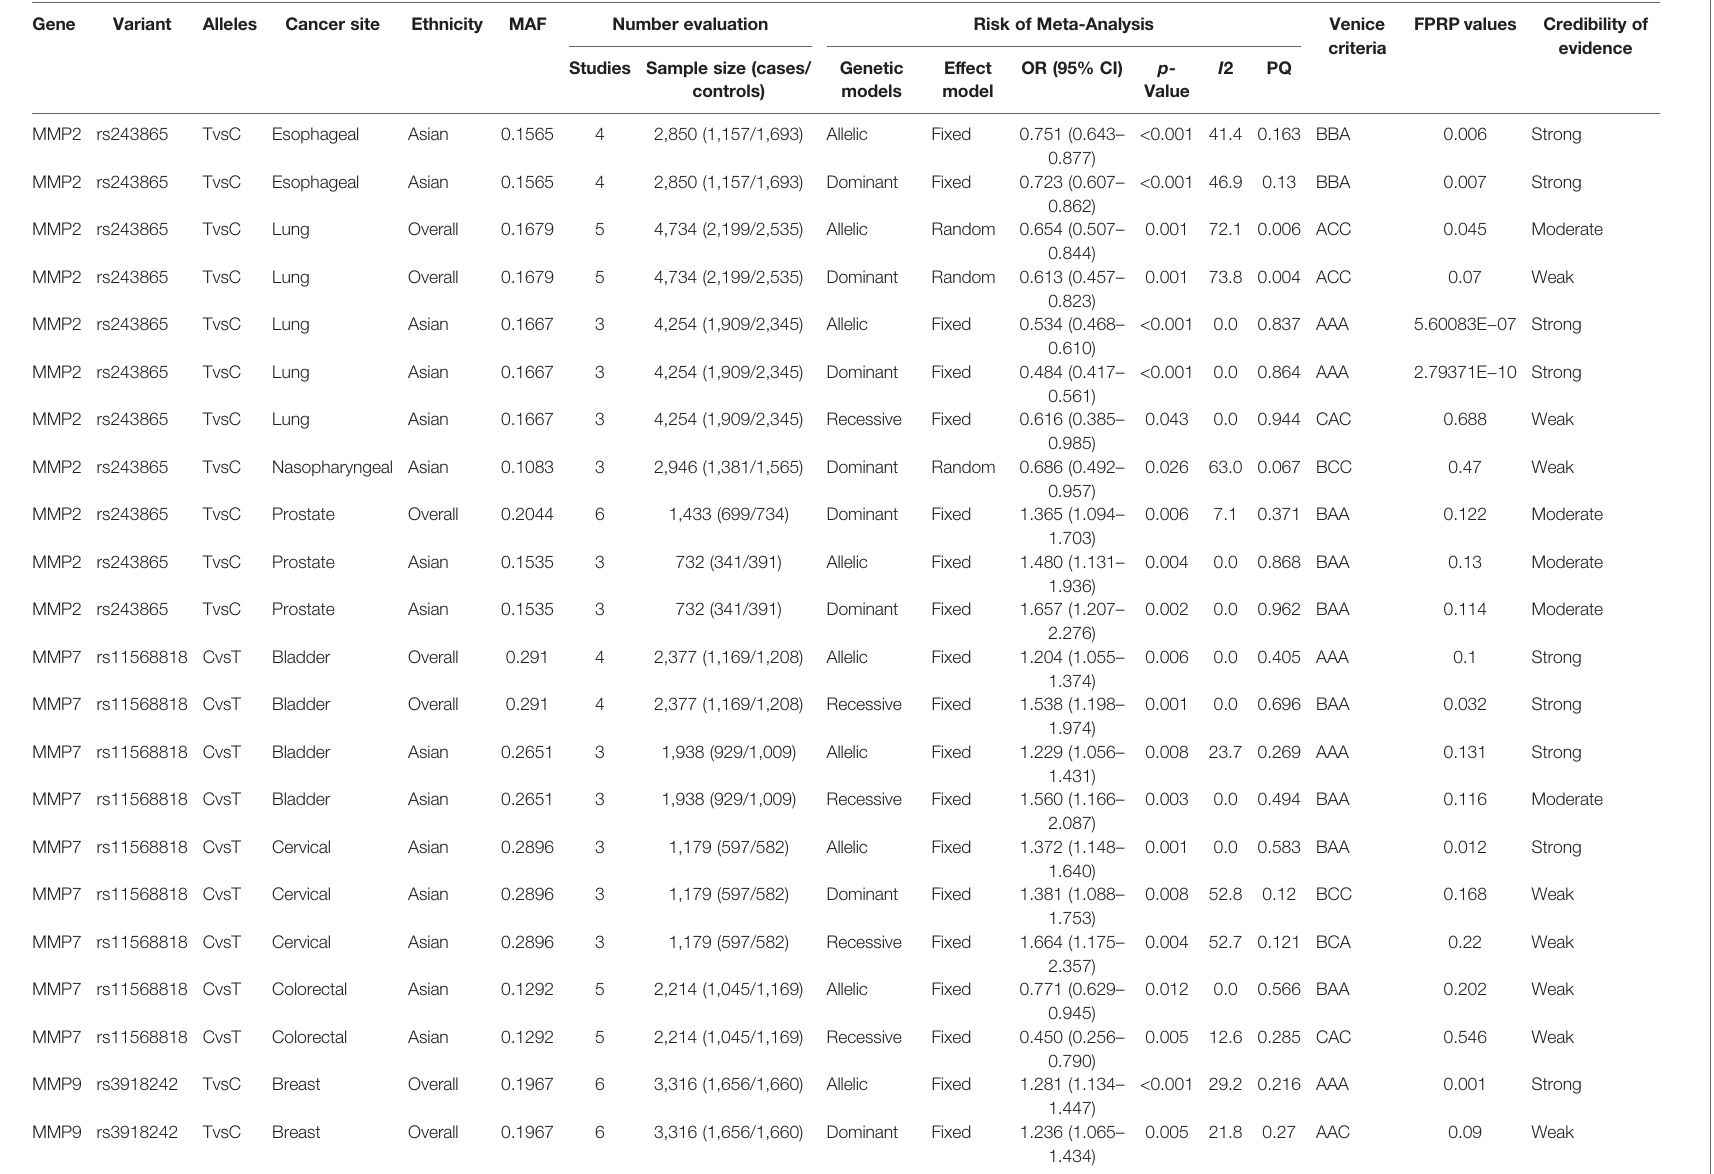
TABLE 1 | Signi fi cant associations between variants in the MMP-2 , MMP-7 , and MMP-9 and cancer